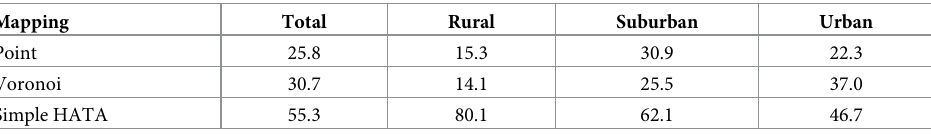
Table 3. Geographical overlap with true coverage area